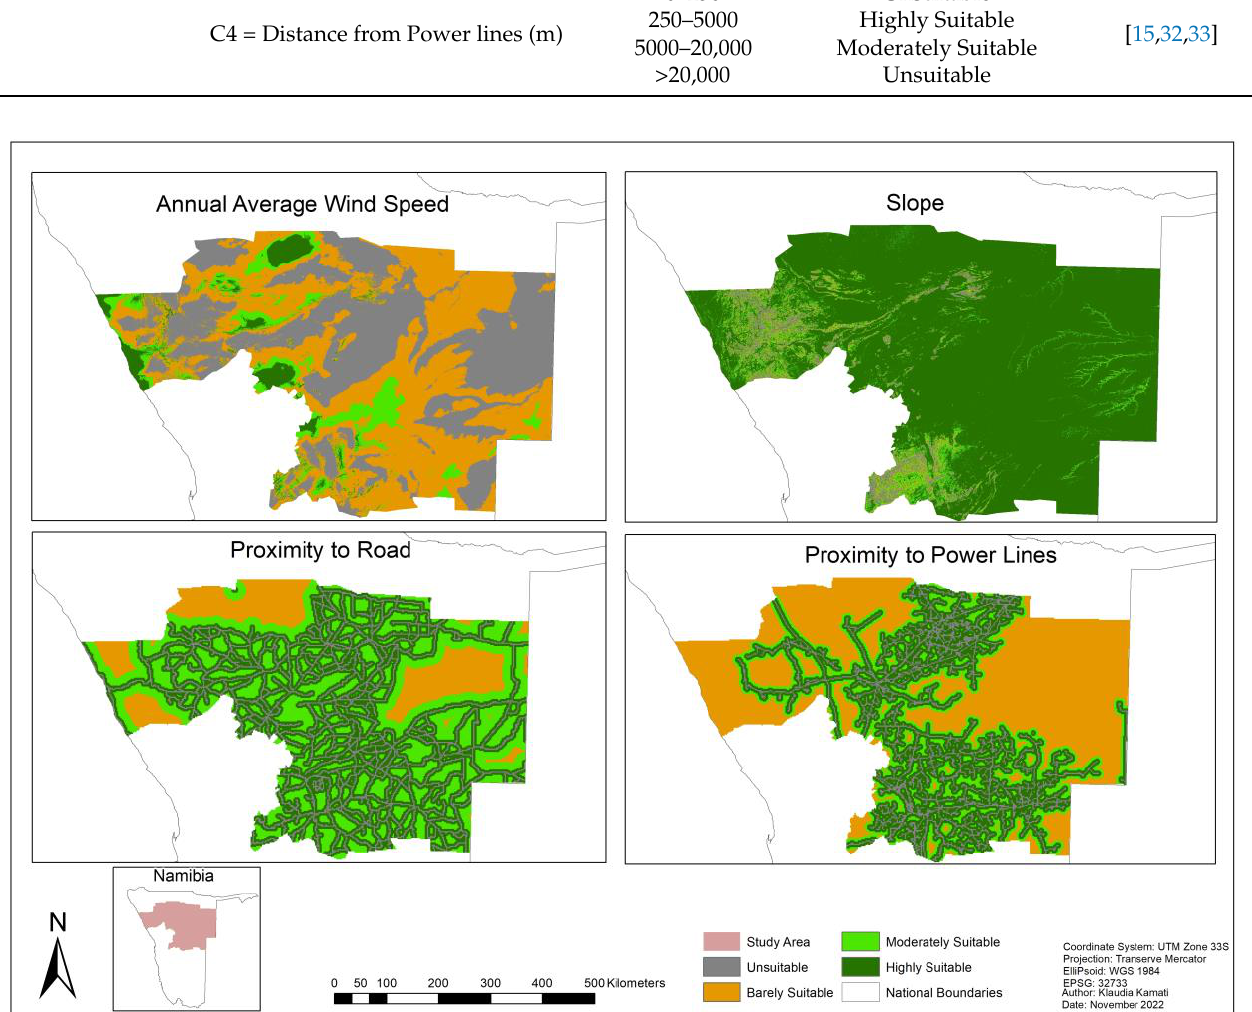
Figure 9. Wind power plant criteria.